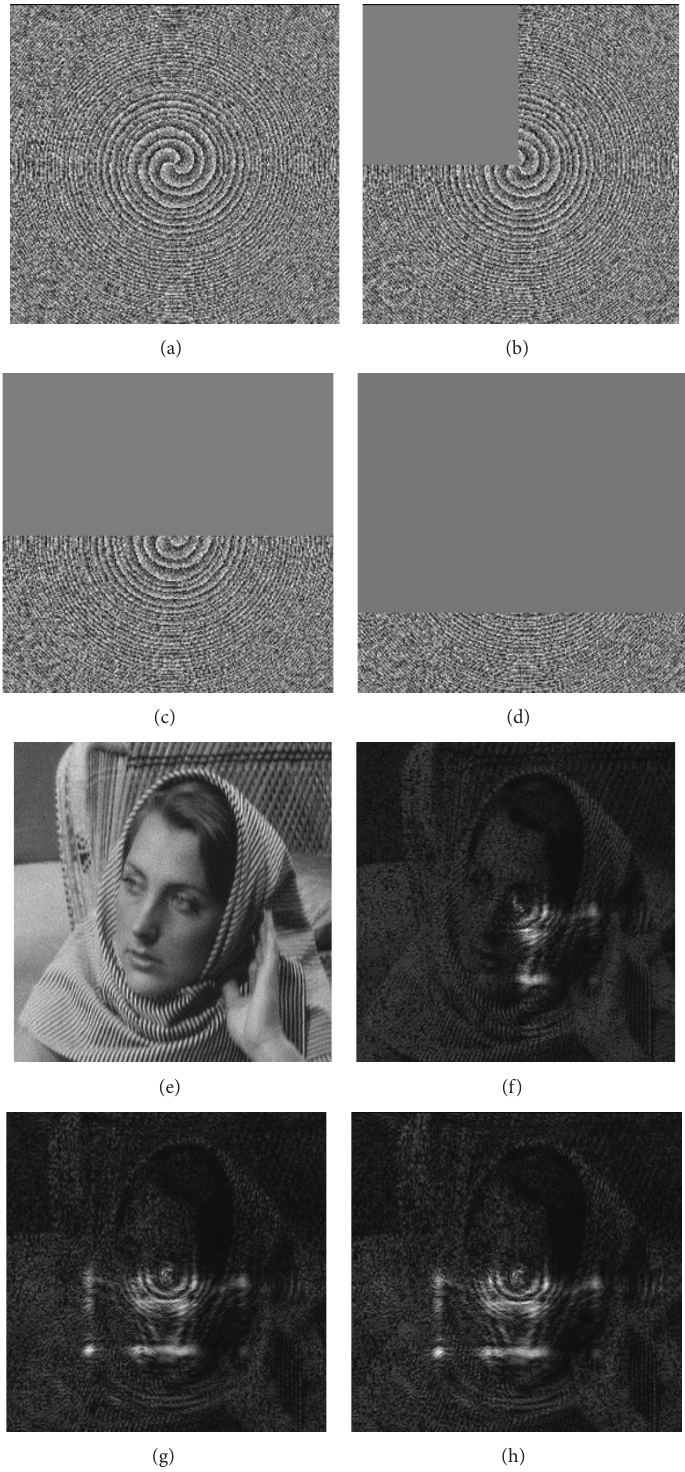
Figure 7: Impact of occlusion attack on decryption phase key. (a)Without occlusion, (b) 25% occlusion, (c) 50% occlusion, (d) 75% occlusion, and (e)–(h) corresponding retrieved